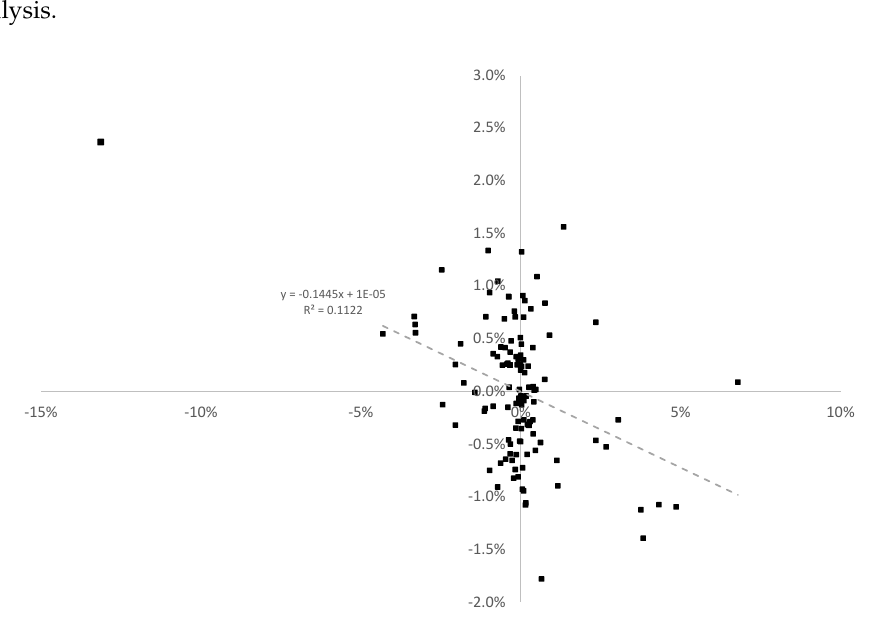
Figure 7. Percentage change in GBPUSD FX spot rates [y-axis] vs. the change in the leave probability from betting markets [x-axis] (12 January to 23 June 2016), with linear regression excluding the ( − 13%, +2.4%) outlier on 20 June 2016.